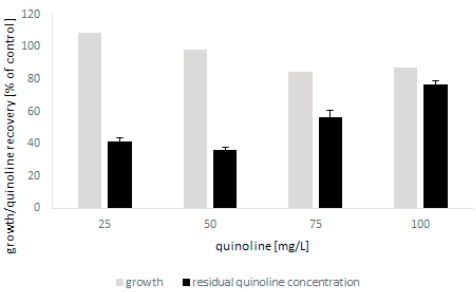
Figure 2. The growth of C. lunata IM 4417 in the presence of quinoline and its elimination during 48 h of incubation. Table 1. LC-MS/MS results of quinoline biotransformation by C. lunata IM 4417. Mass Spectrum m/z (Rel- Retention Chemical Metabolite Compound Metabolite Name ative Intensity of 8 Larg- Time [min] Formula Mass (Da)